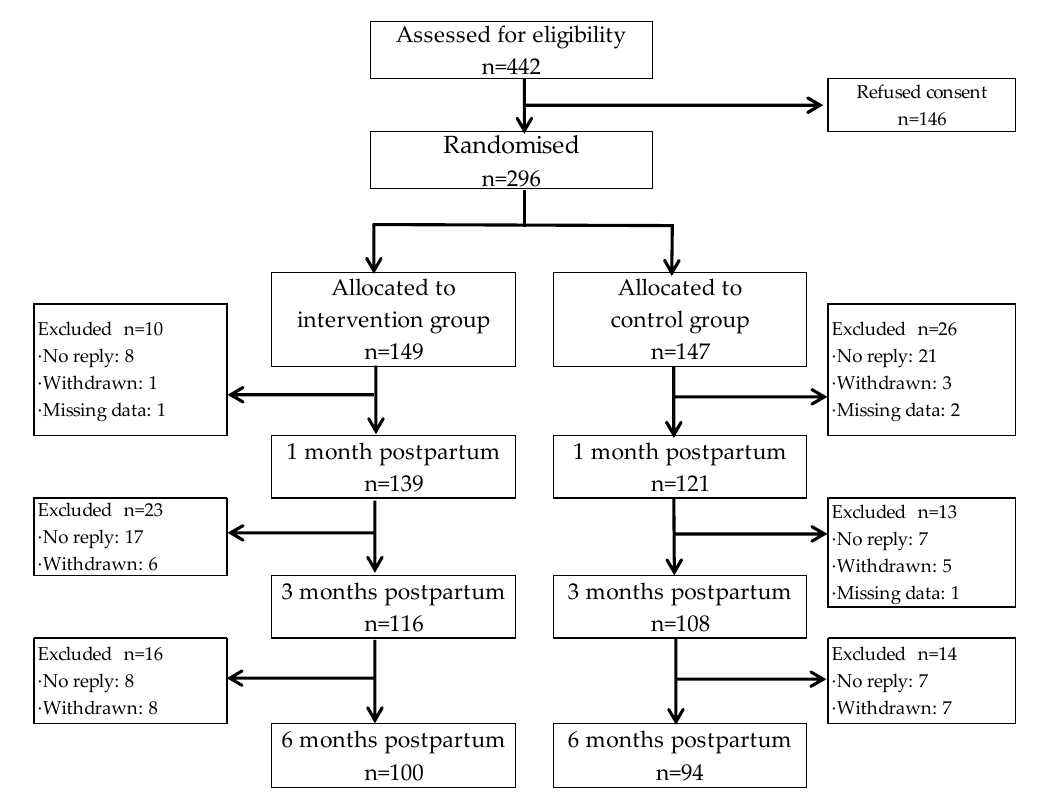
Figure 1. Study flow chart.